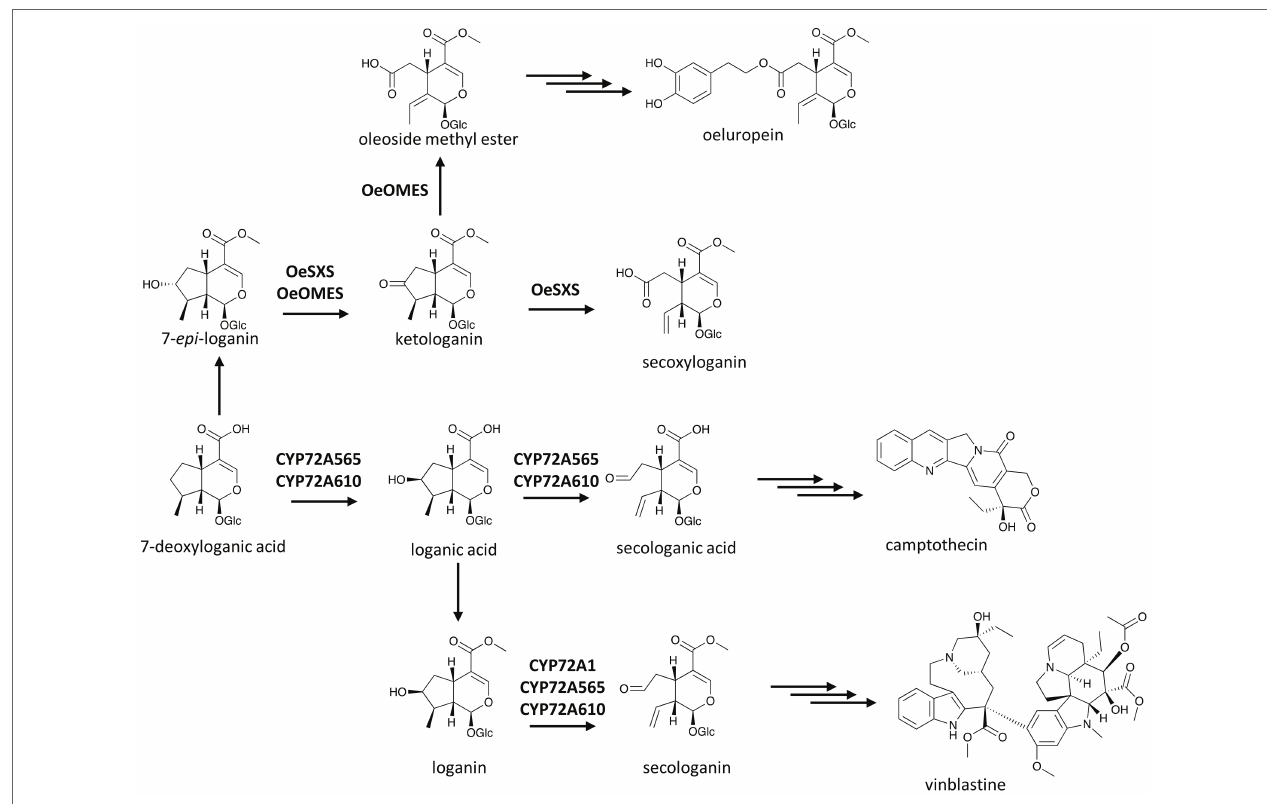
FIGURE 5 | P450s in the terpenoid scaffold formation of MIAs. Multiple and single arrows indicate multiple- and single-step pathways, respectively. Enzymes indicated here are discussed in the